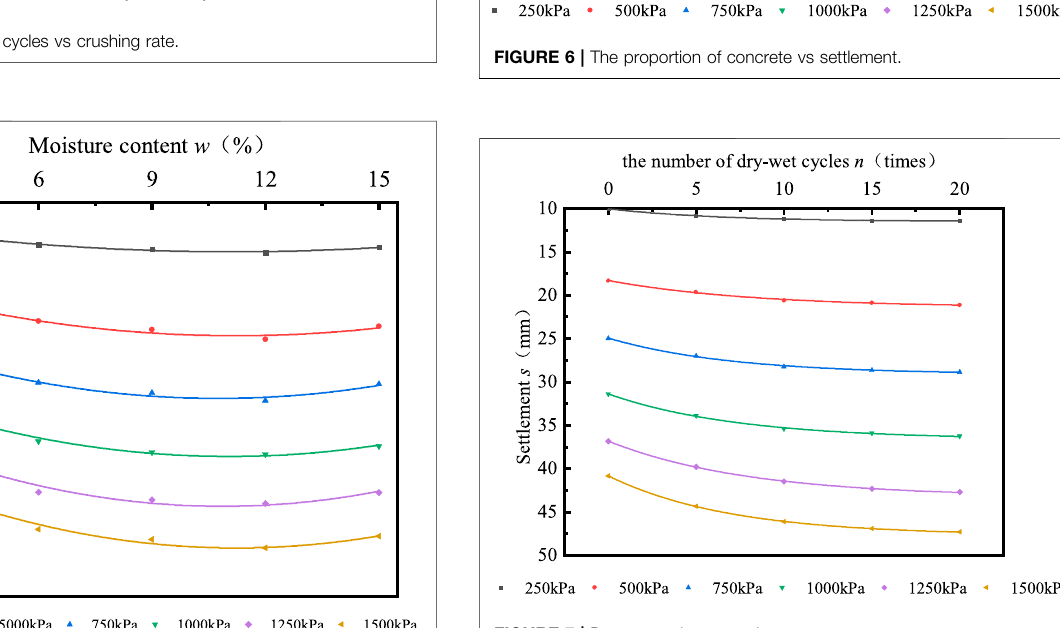
FIGURE 7 | Dry-wet cycles vs